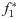
POC-RD alone cannot reverse selection on cost-free pneumococcal resistance.The minimal cost of resistance (f1*) that allows universal treatment without causing an increase in strain 1 resistance is plotted (contour lines) against the expected duration of carriage. Two POC-RD scenarios are shown: with (Z1I=0) and without (Z1I=1) transmission control. Arrows on the x axis are serotype-specific mean carriage duration estimates from [35] (serotypes with ≥15 recorded carriage episodes only). The remaining parameters (rates per day) are d = 0.001, ϕ1C = 5 × 10−4, ϕ2C = 0, γ1I=γ2I = 1, γ0I = 0.125. We make the simplifying assumption that baseline carriage and infection transmission rates are identical (βC = βI = β) which ensures that f1* does not depend on β. Details on parameterization are in S1G Text. POC-RD, point-of-care resistance diagnostics.